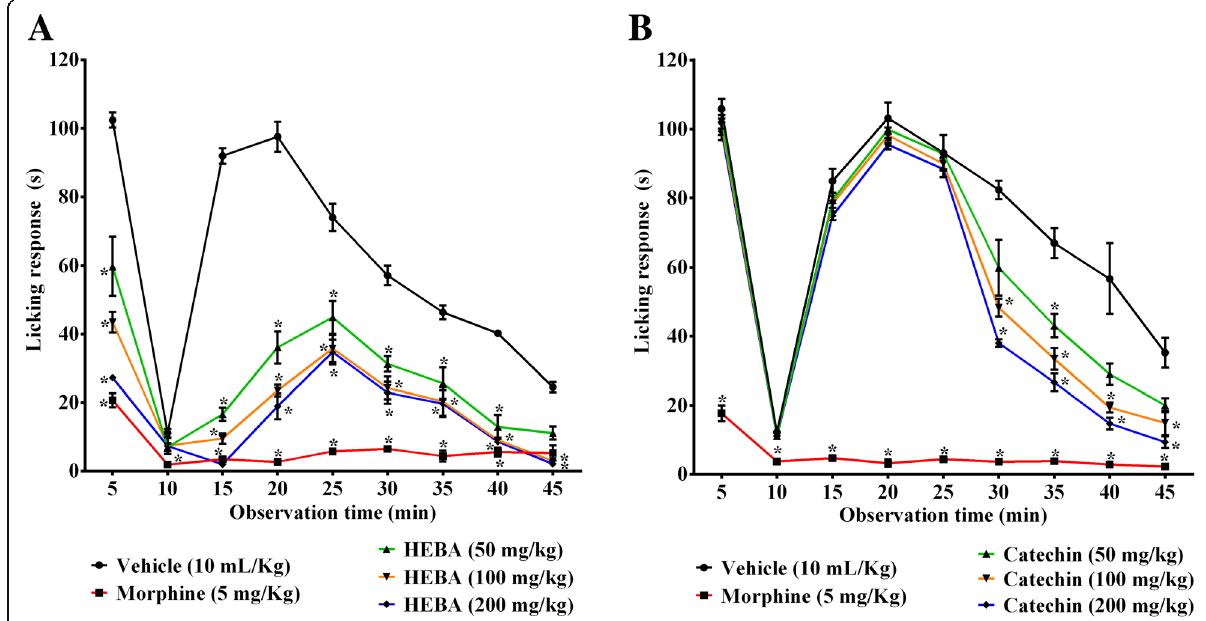
Fig. 5 Effect of morphine, HEBA (panel a ) and (+)-catechin (panel b ) treatments on licking time at multiple time interval in formalin-induced nociception test. Data are presented as mean ± SEM ( n = 5). * represents p < 0.001 at the same time interval, compared to control group mice. HEBA= hydro-methanolic extract of the bark of A.